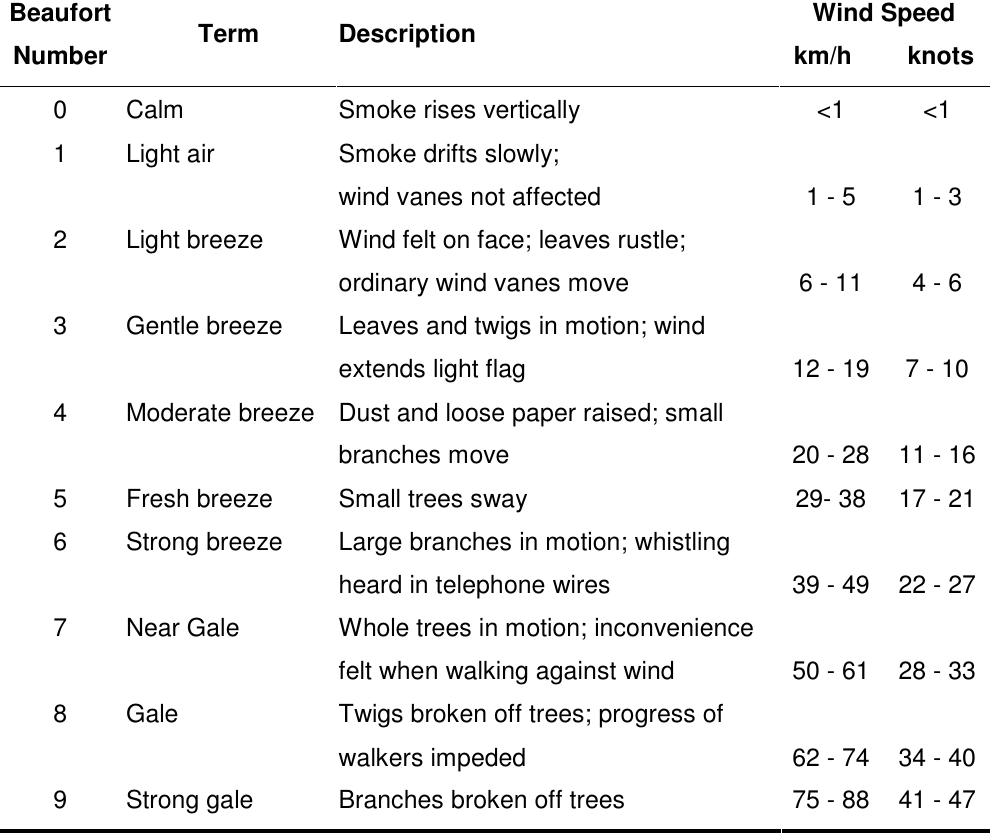
Table 2. Beaufort scale for estimating wind velocity.